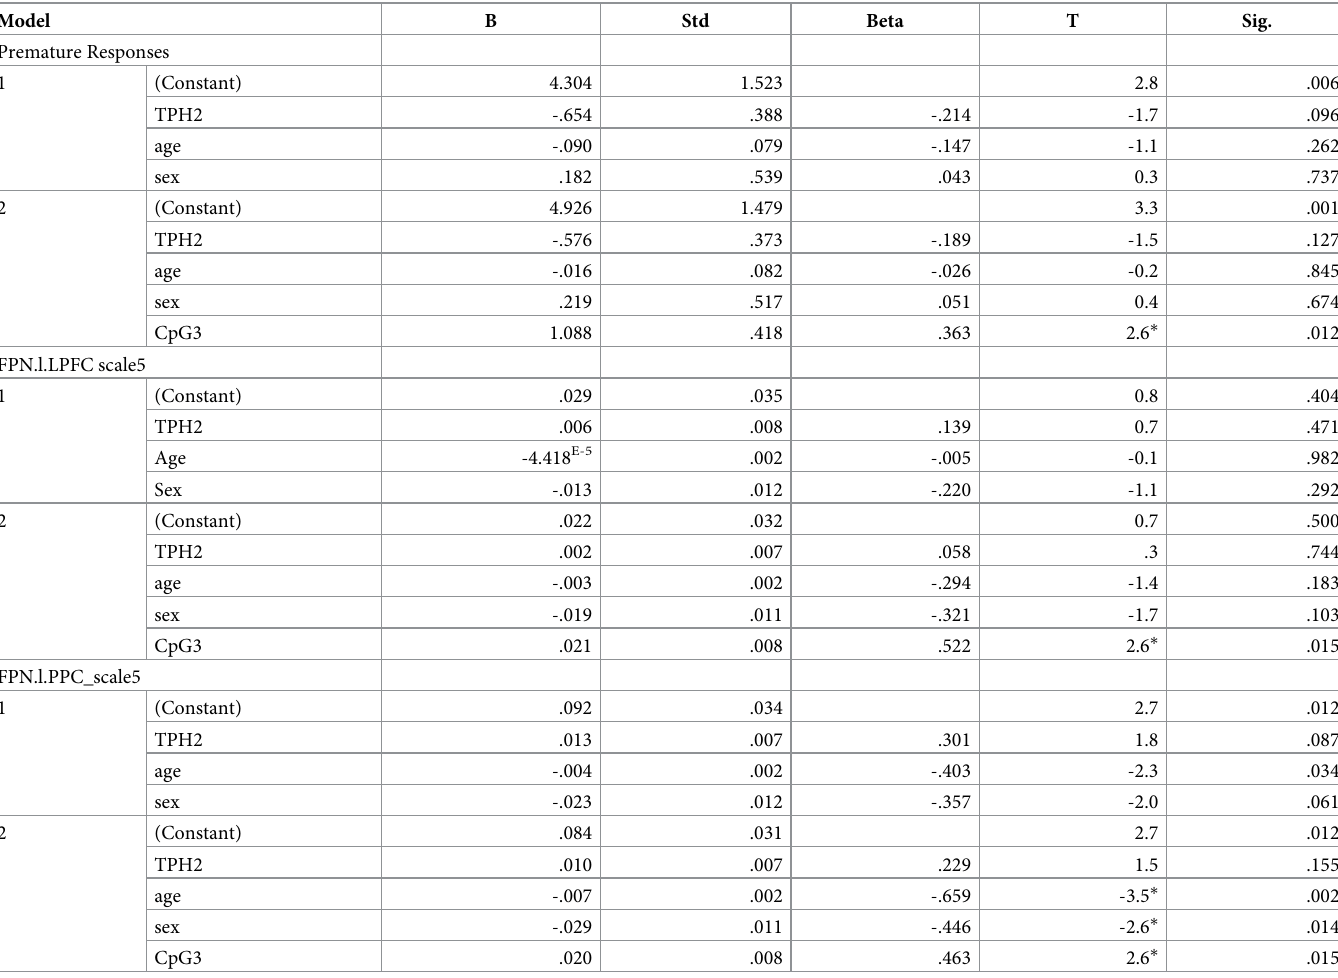
Table 4. Prediction of WI (ROI- and scale-specific wVar and behavioral performance): Results of the multiple stepwise regression analysis.